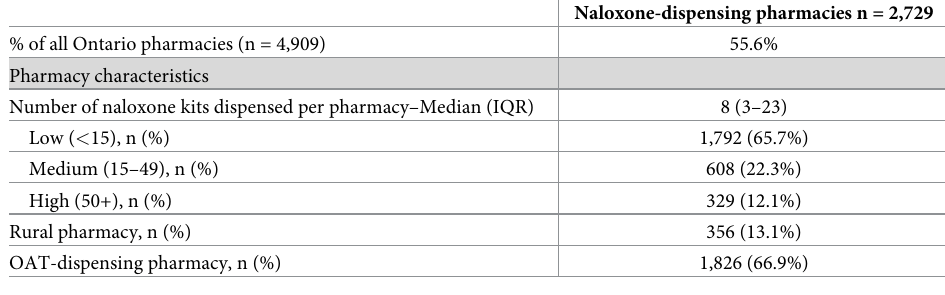
Table 2. Characteristics of pharmacies dispensing naloxone between July 2016 and March